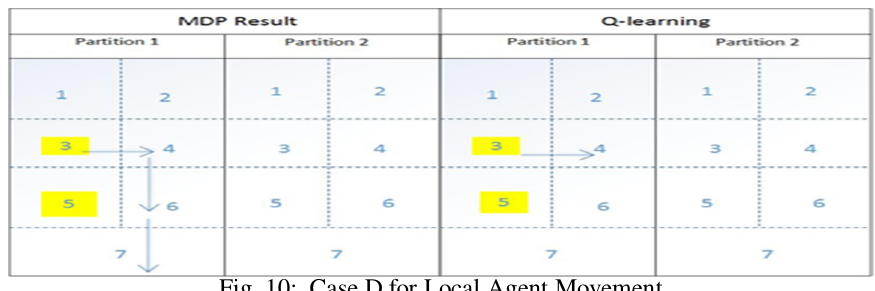
Fig. 10: Case D for Local Agent Movement